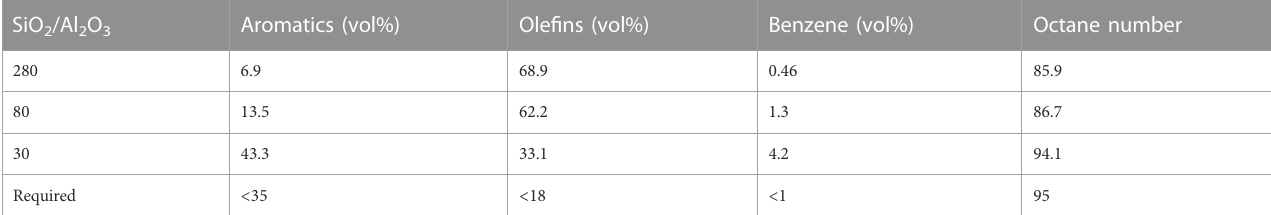
TABLE 7 Comparison of gasoline fraction fuel properties achieved with various SiO 2 /Al 2 O 3 ratios using three HZSM-5 types (Artetxe et al., 2013b). SiO 2 /Al 2 O